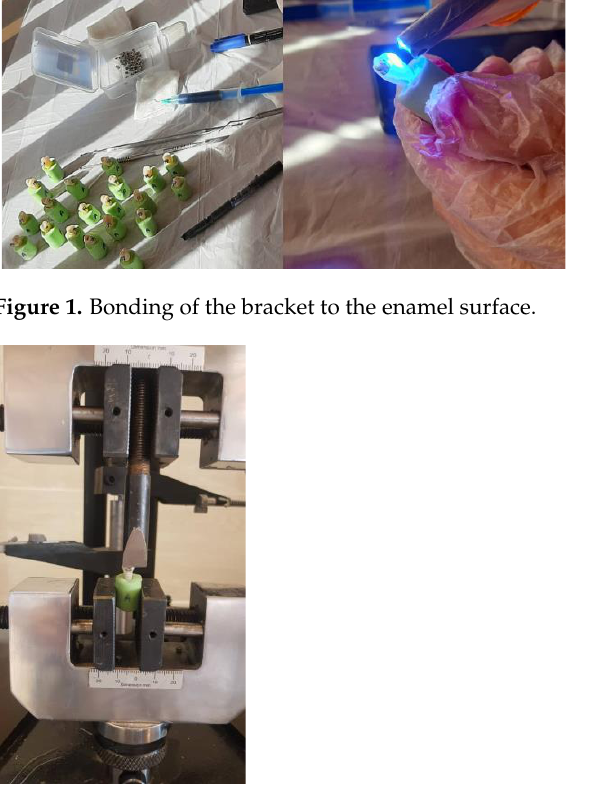
Figure 2. Positioning of a sample in the universal testing machine.